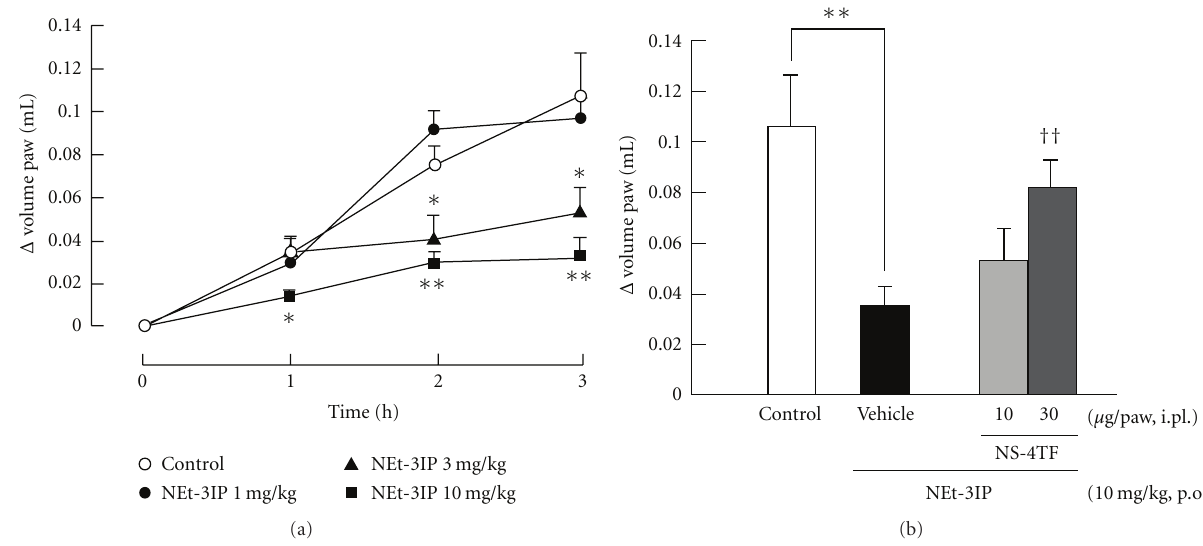
Figure 3: Involvement of RXR on carrageenan-induced paw edema in mice . (a) Dose dependence and time course of RXR agonist, NEt-3IP on carrageenan-induced paw edema in mice. NEt-3IP was orally administrated 3h before carrageenan injection at doses of 1, 3, and 10mg/kg. The control group was received 0.5% carboxymethylcellulose. (b) E ff ect of RXR antagonist, NS-4TF on NEt-3IP induced anti-inflammatory e ff ect. NEt-3IP was orally administrated 3h before carrageenan injection at a dose of 10 mg/kg. NS-4TF was injected 15 min before carrageenan injection at doses of 10 and 30 μ g/paw. The vehicle group received physiological saline including 10% dimethylsulphoxide. Each column and vertical bar represents the means ± S.E.M. ( n = 7). ∗ , ∗∗ : Significantly di ff erent from the control group at P < 0 . 05 and P < 0 . 01, respectively, (Dunnett’s test). †† : Significantly di ff erent from the vehicle group at P < 0 . 01 (Dunnett’s